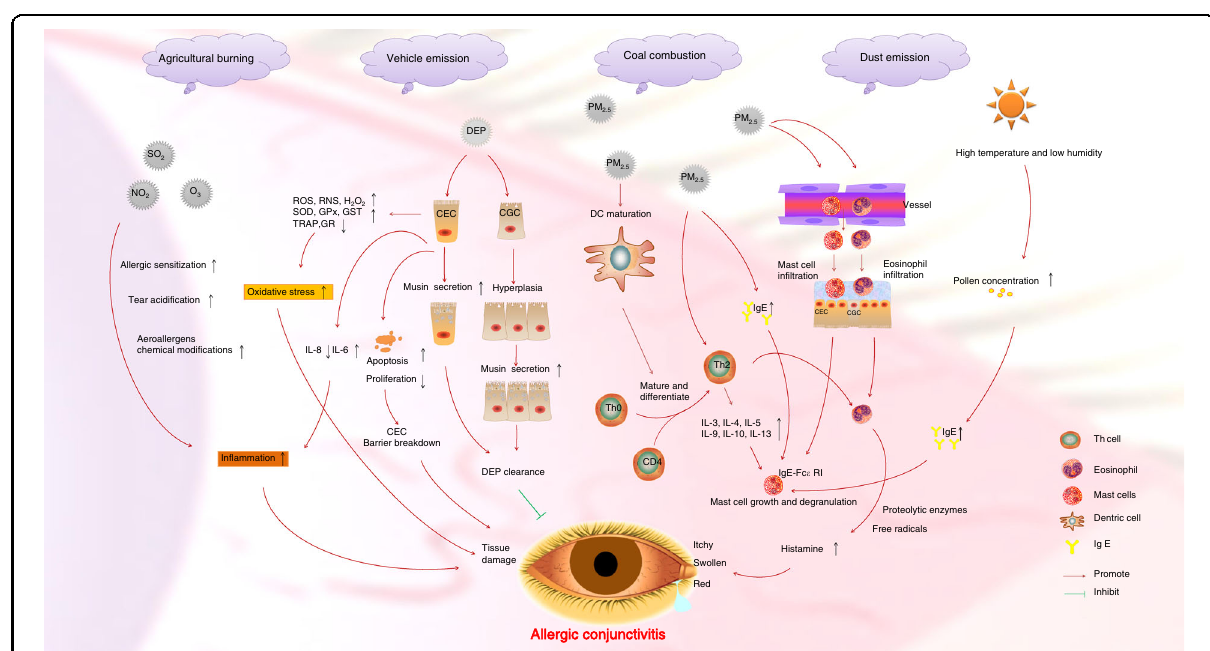
Fig. 6 The effects and mechanism of air pollution and meteorological factors on AC in Northeast China. NO 2 , SO 2 , O 3 increase allergic sensitization, induce acidi fi cation of the tears, and chemical modi fi cation of aeroallergens. High temperature and low humidity increase pollen concentration. Pollens induce IgE production and IgE attached to the IgE-Fc ε RI complex on mast cells (MGs), activating MGs degradation and releasing histamine. PM 2.5 promotes IgE production, MGs growth, and aggregation of eosinophil cells in fi ltration in the conjunctiva. Allergens were presented by dendritic cells (DC), causing Th0 or CD4 cells to differentiate into Th2 cells, promoting IgE-mediated allergies by releasing IL-3, IL-4, IL-5, IL-5, IL- 9, IL-10, and IL-13, leading to eosinophilic activation and releasing histamine. Diesel Exhaust Particles (DEP) decreased the viability, proliferation, IL-8 expression and increases apoptosis, and IL-6 expression in conjunctiva epithelial cells (CEC). DEP induces conjunctiva goblet cells (CGC) hyperplasia and secrete musin to facilitate DEP clearance. DEP increases the expression of ROS, nitrogen (RNS), hydrogen peroxide (H 2 O 2 ), superoxide dismutase (SOD), glutathione peroxidase (GPx), and glutathione S-transferase (GST). DEP decreases the expression of glutathione reductase (GR) and the total reactive antioxidant potential (TRAP) in CEC, resulting in